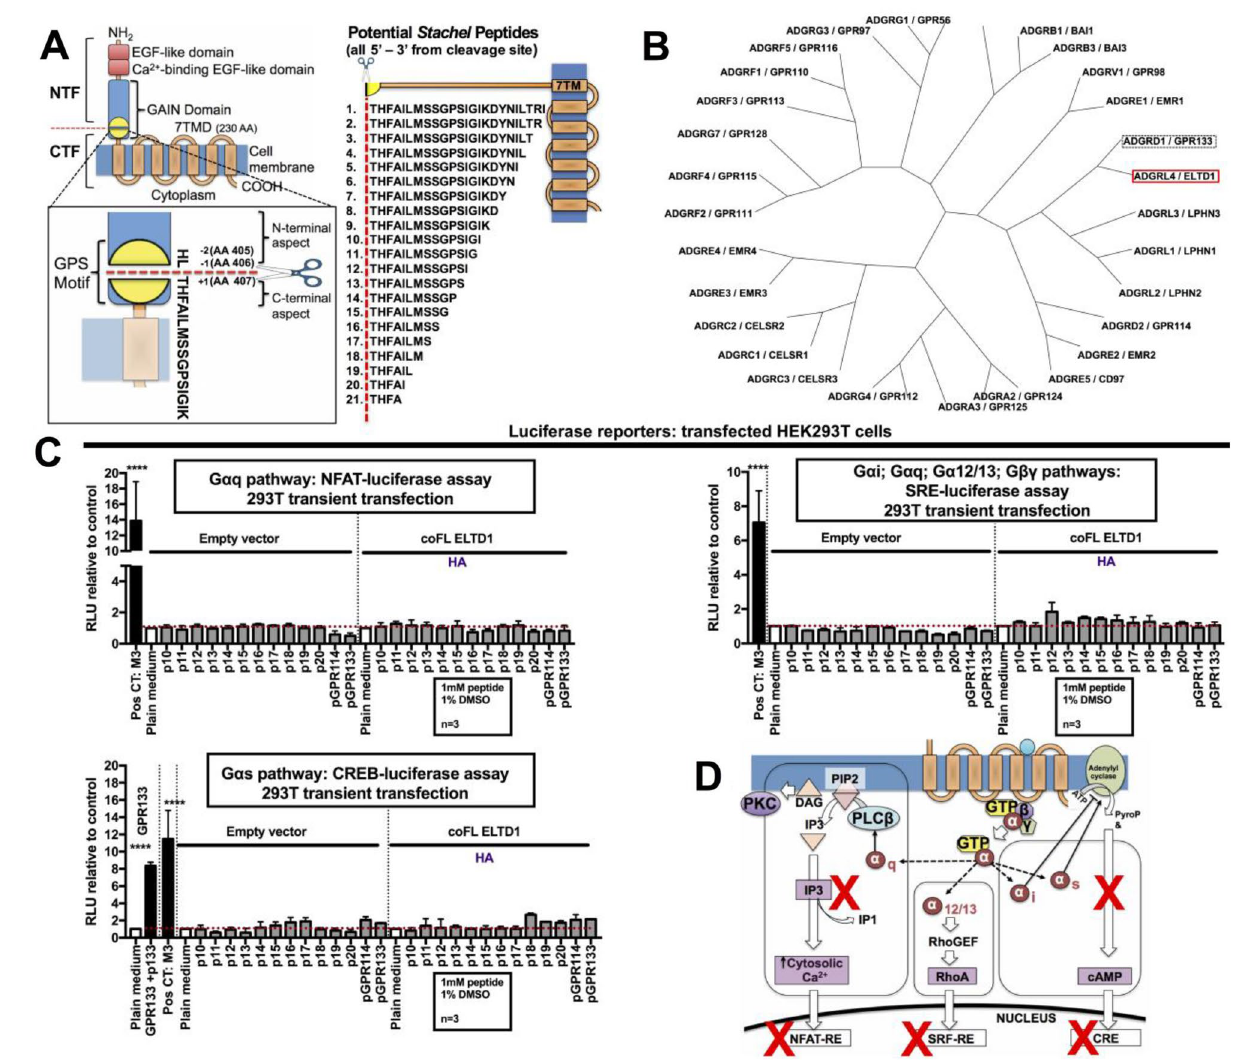
Figure 2. ADGRL4/ELTD1’s putative Stachel peptides do not activate canonical GPCR signalling. ( A ) Design of the 21 putative ADGRL4/ELTD1 Stachel peptides. ( B ) Radial cladogram comparing similarity of all aGPCR GPS domains. ( C ) Gαq, Gαs, Gαi, Gα12/13, Gβγ Stachel peptide luciferase assays in HEK293T cells transfected with co FL ADGRL4/ELTD1. Positive controls used were the CHRM3/M3 GPCR receptor exposed to 10 µM carbachol for Gαq, Gαs, Gαi, Gα12/13, Gβγ ( p < 0.0001) and GPR133 exposed to its Stachel peptide (p133) for Gαs ( p < 0.0001). ( D ) Graphical summary of canonical GPCR signalling pathways investigated in this study. (Abbreviations: Pos CT = positive control; co = codon optimised; FL = full length; NTF = N-terminal fragment; CTF = C-terminal